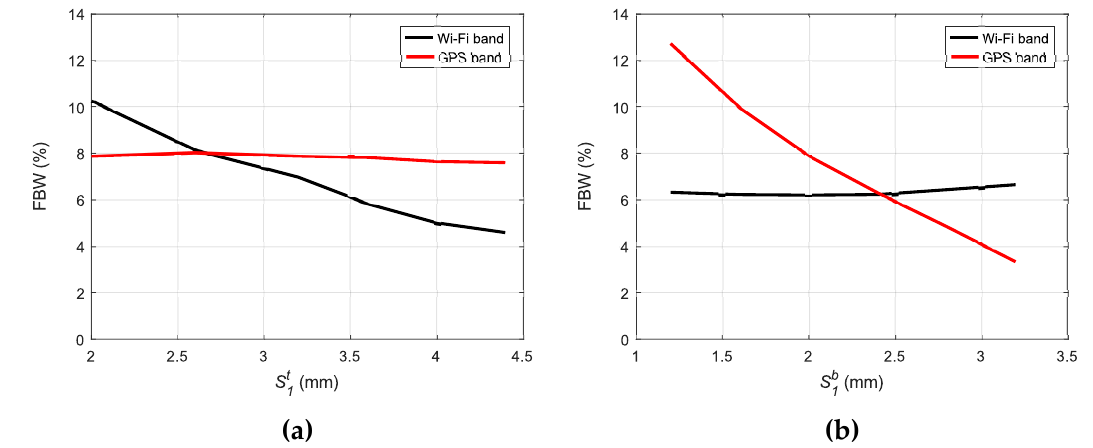
Figure 7. FBW with as a function of the resonators gap: ( a ) s t